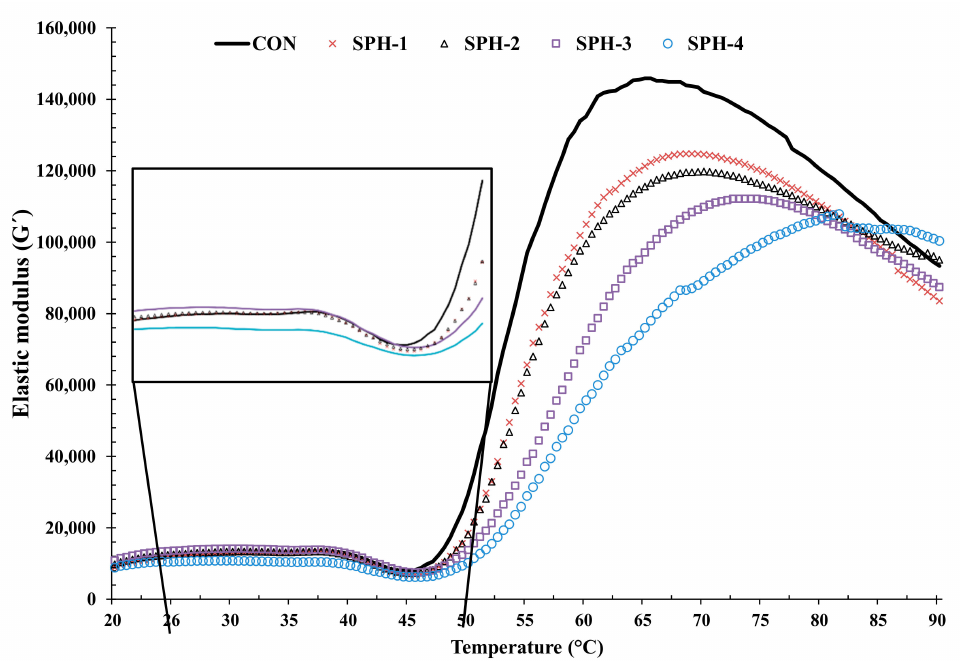
Figure 4. Elastic modulus (G (cid:48) ) during heating (20–90 ◦ C) of threadfin bream surimi paste added without and with psyllium husk at different levels. Caption: See Figure